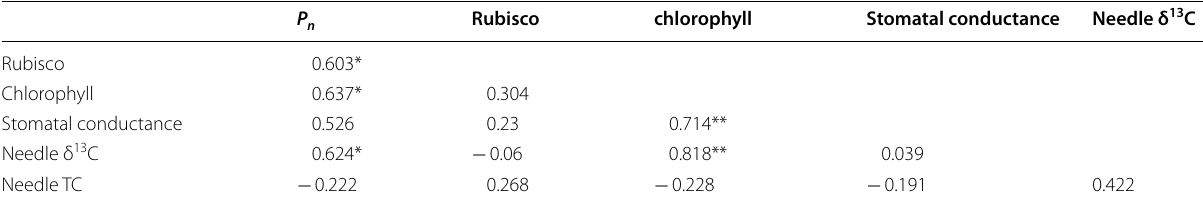
* represents p < 0.05, ** represents p < 0.01